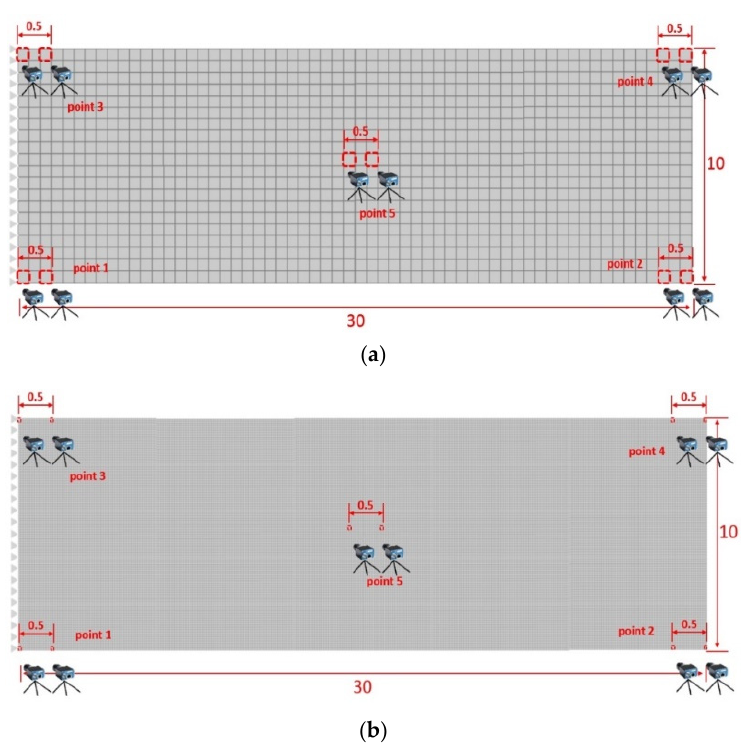
Figure 6. Procedures for estimation (sampling method).